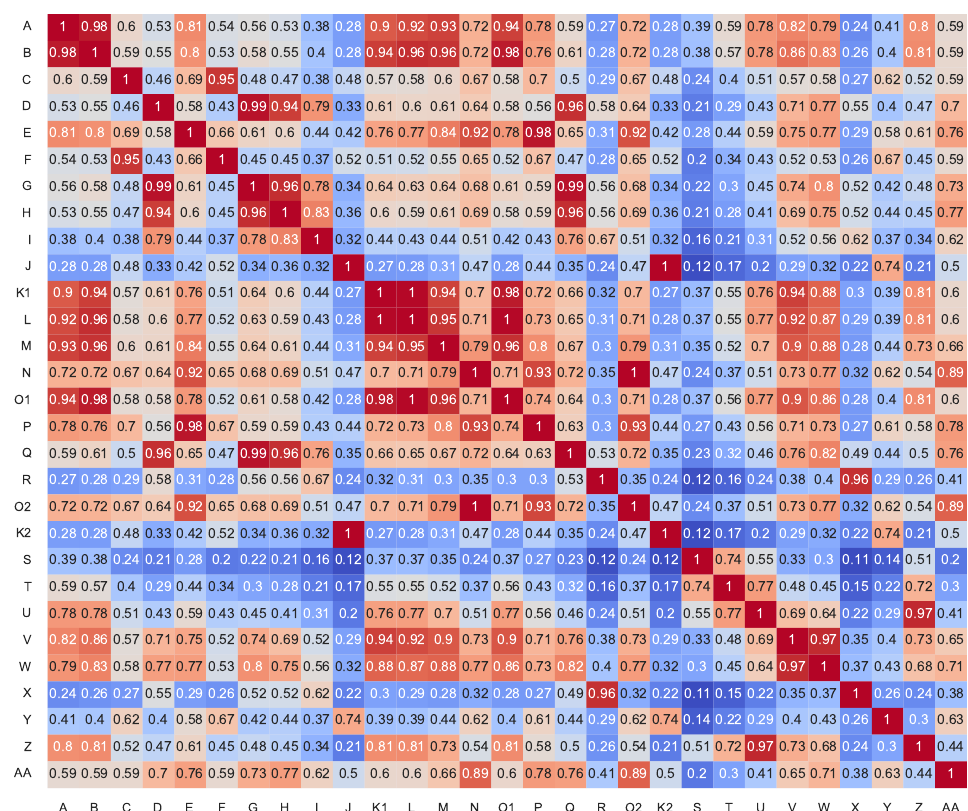
Figure 8. Correlation matrix of wind speed of considered wind farms. Shown are pairwise correlation coefficients, each calculated from the two vectors of hourly wind speeds from the respective sites. For clearer representation, the matrix elements are colored from dark blue (correlation is equal to − 1) to dark red (correlation is equal to